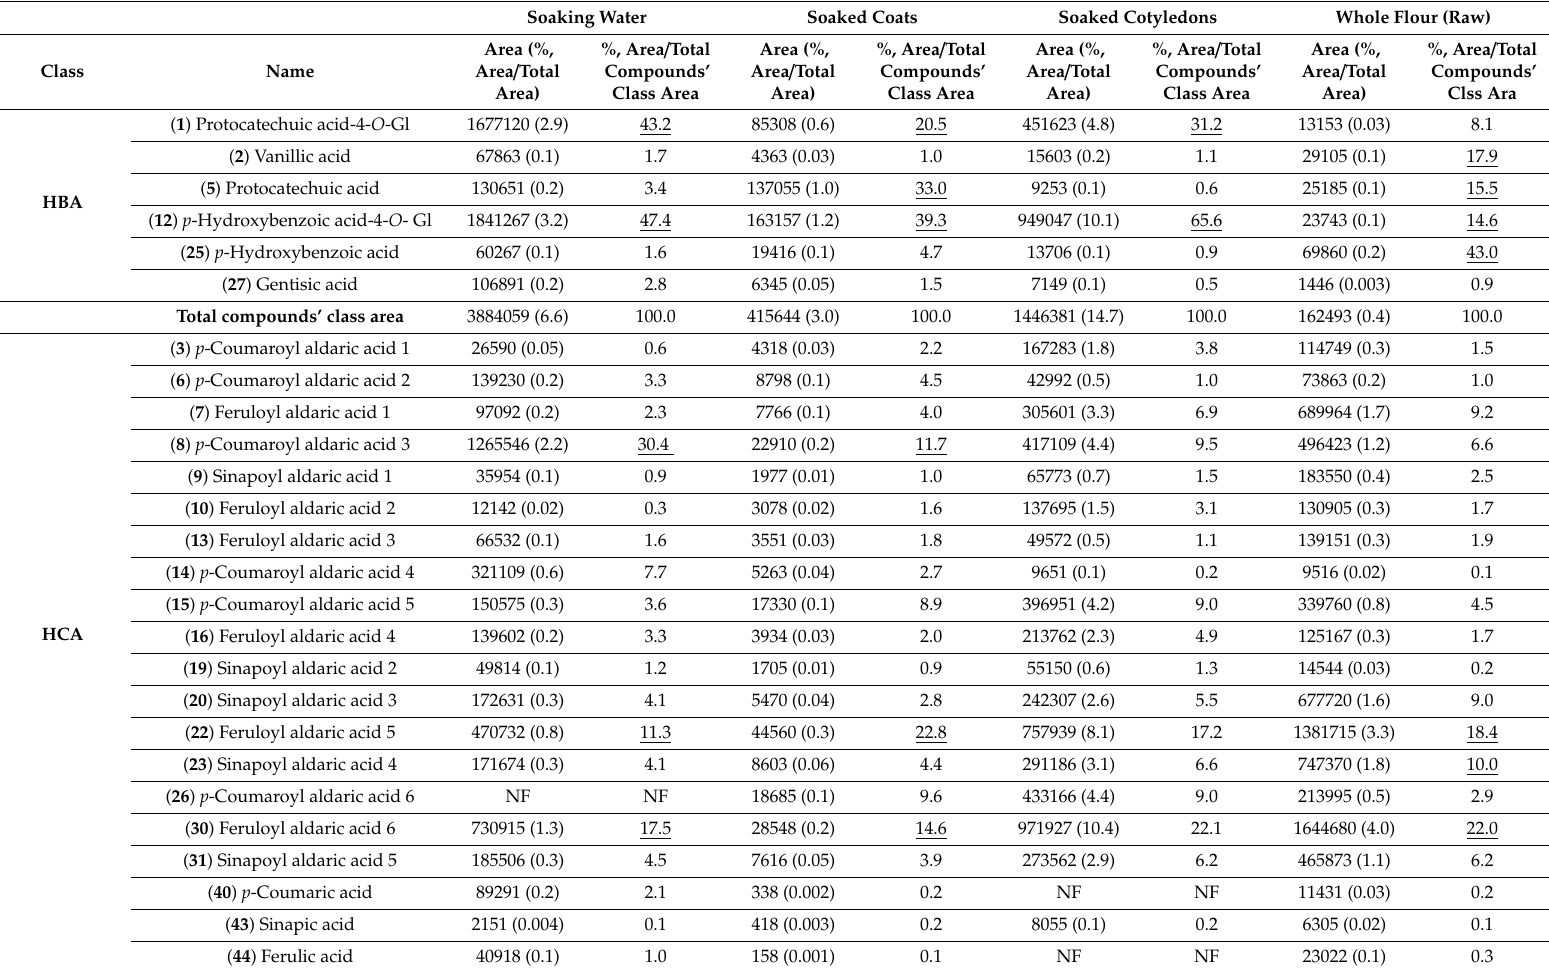
Table 4. Relative quantification of identified compounds in sample’s 22